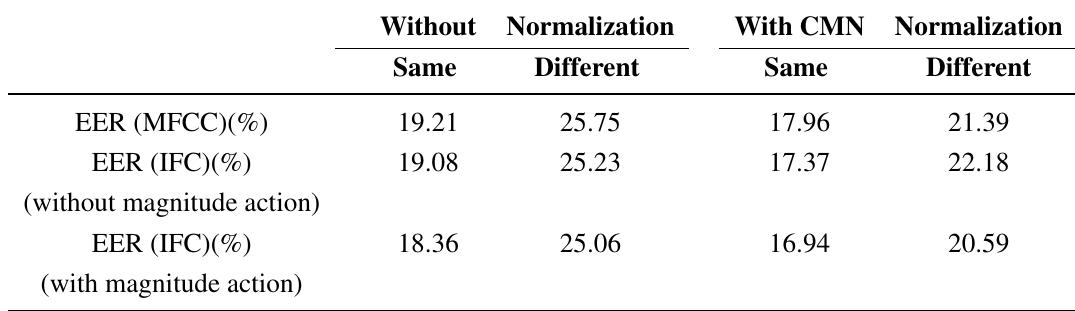
Table 1. Illustration of the speaker recognition system performance in term of equal error rate (EER) for MFCC and invariant features in match (same) and mismatch (different) cases with and without cepstral mean normalization (CMN) normalization. IFC, invariants feature